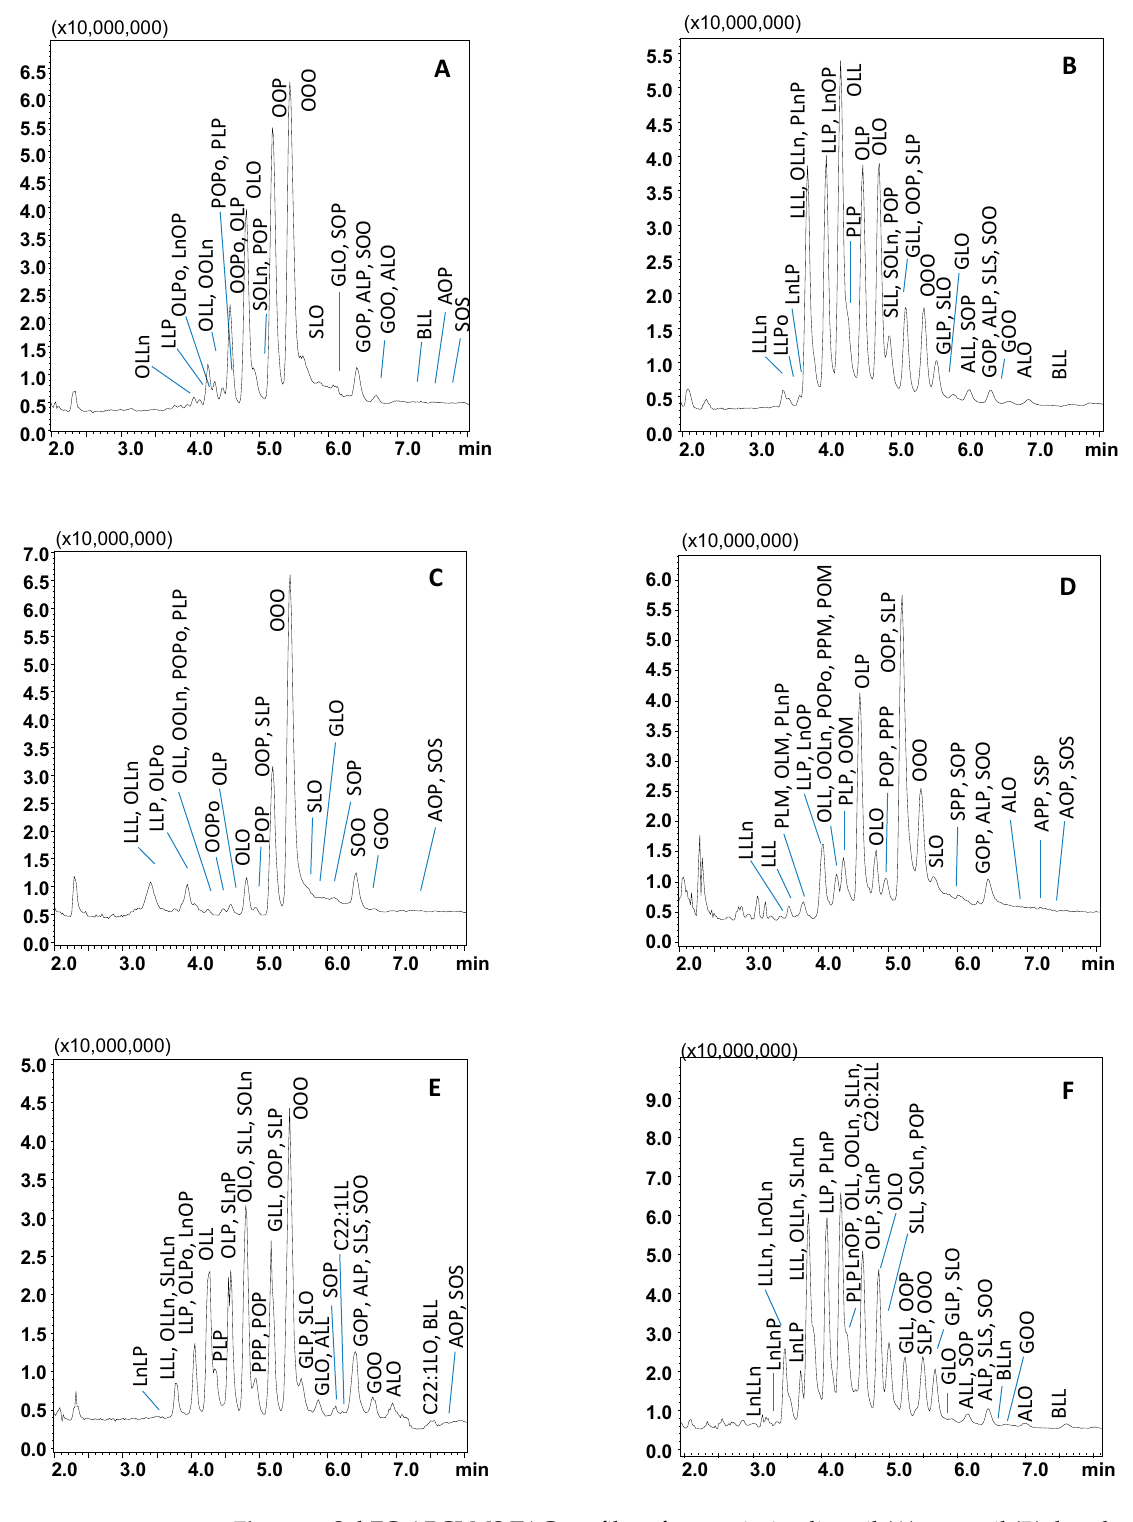
Figure 2. SubFC-APCI-MS TAG profiles of extra virgin olive oil ( A ), corn oil ( B ), hazelnut oil ( C ), palm oil ( D ), peanut oil ( E ), soybean oil ( F ). Relevant part of the TAGs elution region, employing a gradient of AcN into CO 2 . Column: Ascentis Express C18, 100 × 30 mm L × i.d., 2.0 μ m d.p. , partially porous. Column temperature, 20 °C; ABPR, 150 bar and 50 °C; gradient elution of AcN into CO 2 , 0–5 min, 5% B, 5–15 min, to 20% B at 1.0 mL/min. Injection volume, 2.0 μ L. Peak labeling as in Table 1.